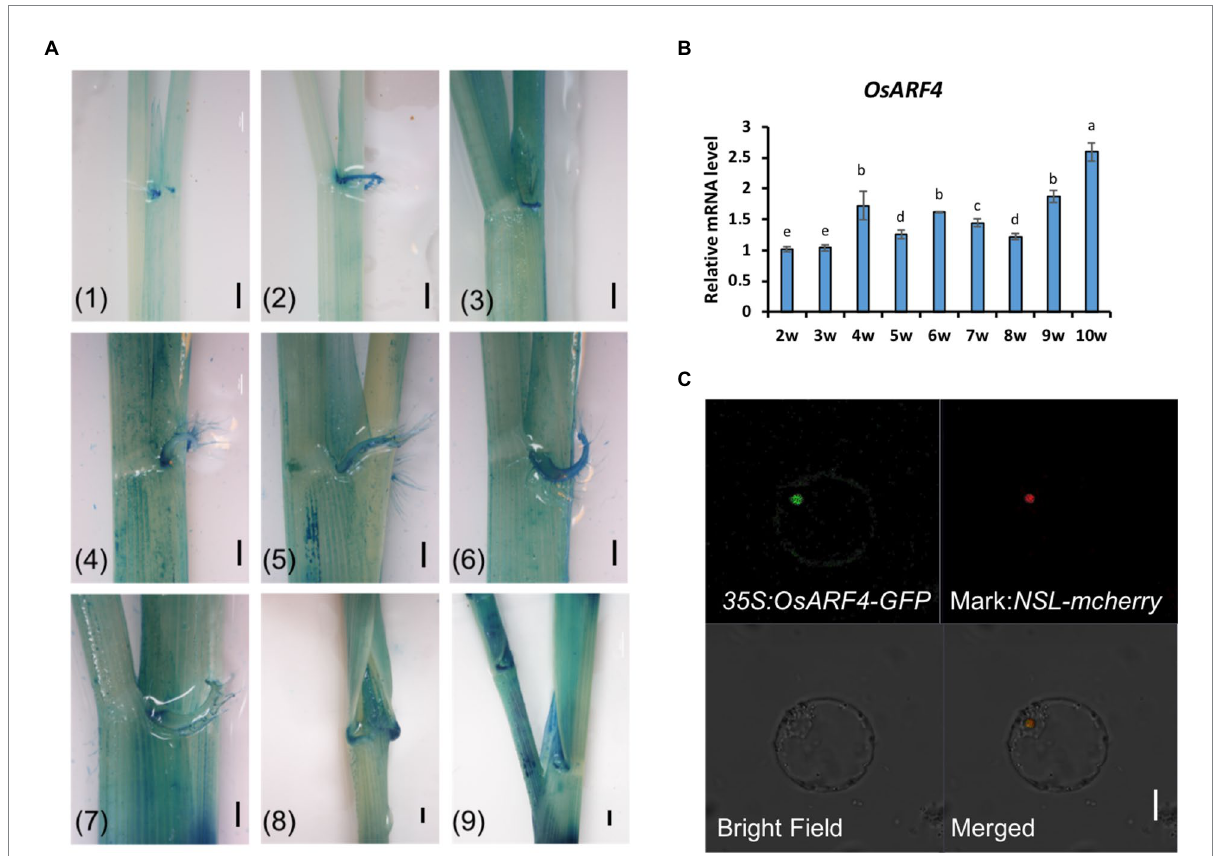
FIGURE 1 Expression patterns of the OsARF4 gene and subcellular localization of OsARF4. (A) The expression patterns of the OsARF4 gene. (1)–(9) show GUS staining of 2, 3, 4, 5, 6, 7, 8, 9, and 10-week-old seedlings, respectively. Scale bar = 1 mm. (B) qRT-PCR analysis of OsARF4 expression in WT/DJ rice. Three separate biological replicates were used in this experiment. Error bars represent SD ( n = 3). Lowercase letters represent significance according to Duncan’s multiple range test ( 𝛼 = 0.05). (C) Subcellular localization of OsARF4 in rice. 35S:OsARF4-GFP and the nuclear localization marker NLS- mCherry were transiently coexpressed in rice protoplasts. Scale bar = 20